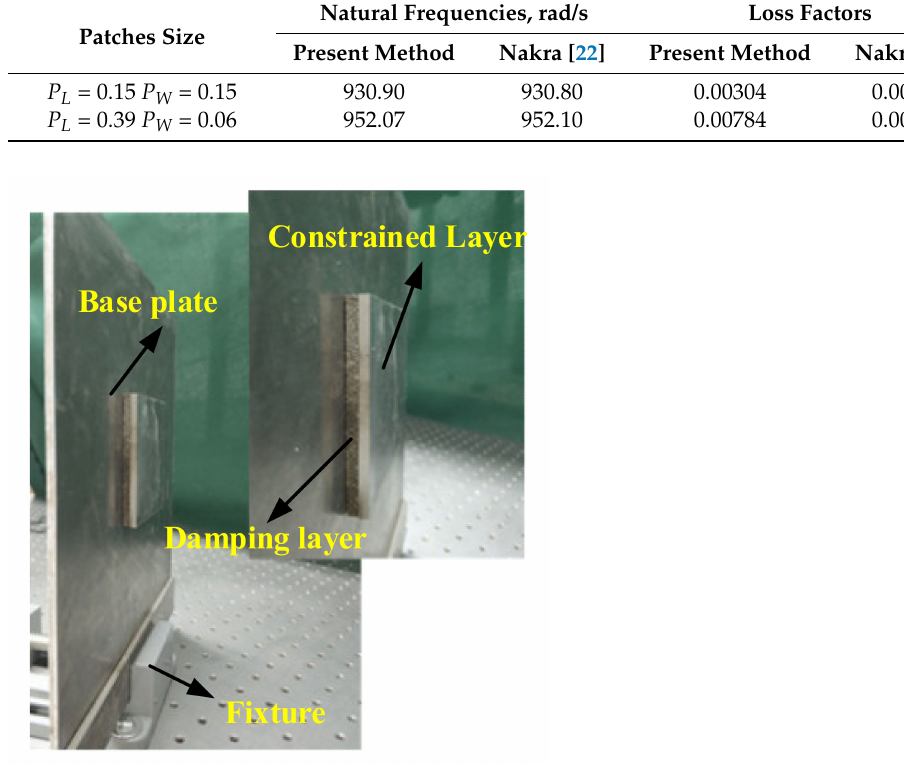
Figure 5. Experimental composite plate.